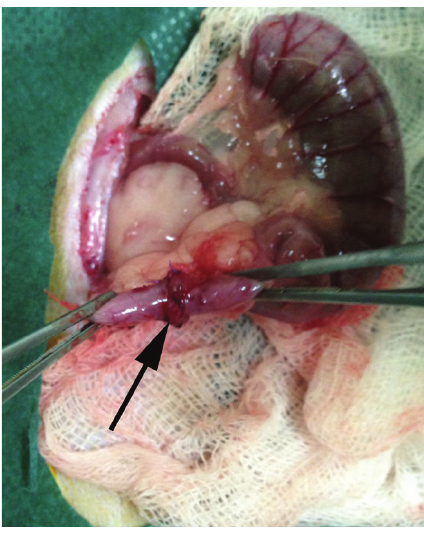
Figure 1: Intraoperative photo, depicting the newly constructed anastomosis (black